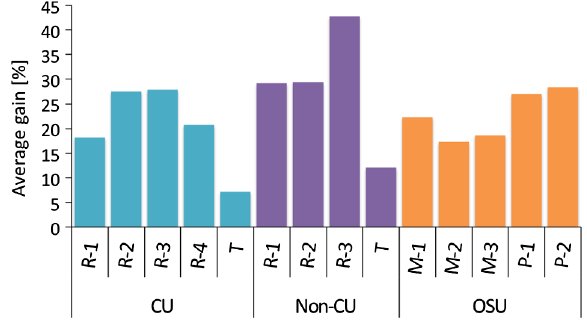
FIG. 5. The average CUE gain across different institutions. R denotes the PER-based courses, T the standard lecture-based courses, and P the data from OSU. For comparison, we also present gains from the first midtest ( M ). Data for CU and non-CU gains adapted with permission from Ref. [5].